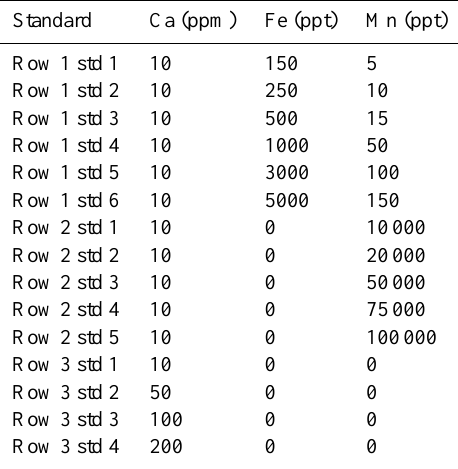
Table A3. Element concentration for the different standard rows used for ICP-MS.